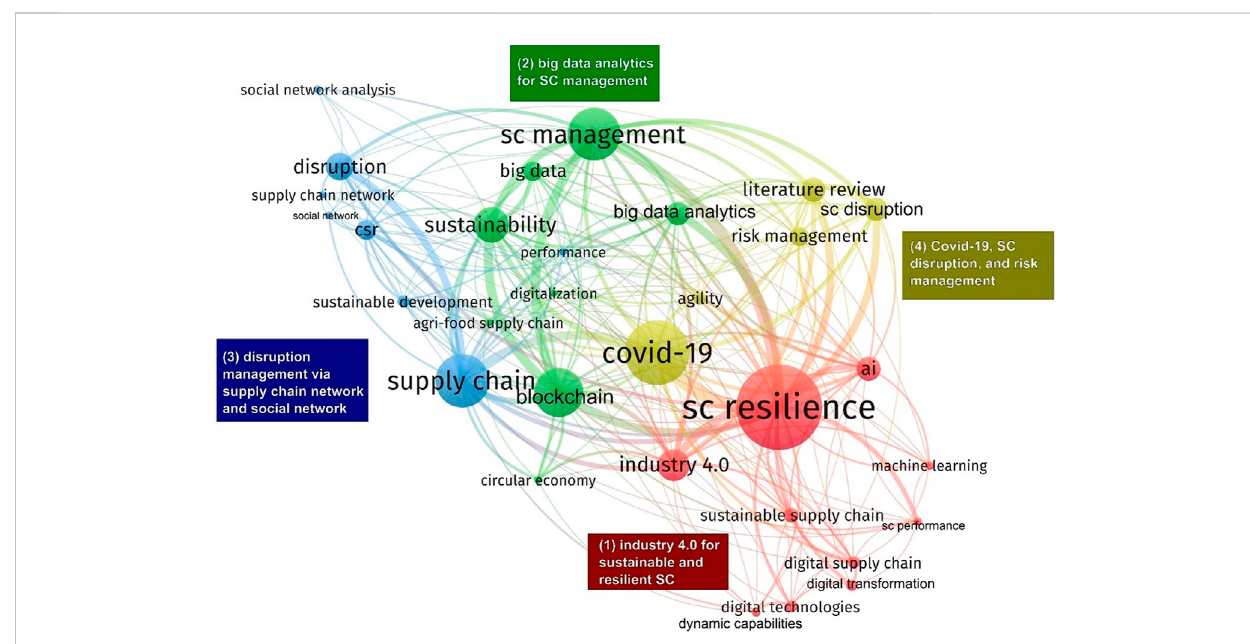
appear in the upper right quadrant of the strategy map in Figure 4. (cid:129) “ Niche themes ” are developed, but less signi fi cant (i.e., more peripheral) to the overall domain knowledge. They are depicted the upper left quadrant of the strategy map. (cid:129) “ density) and not as relevant (low centrality). These